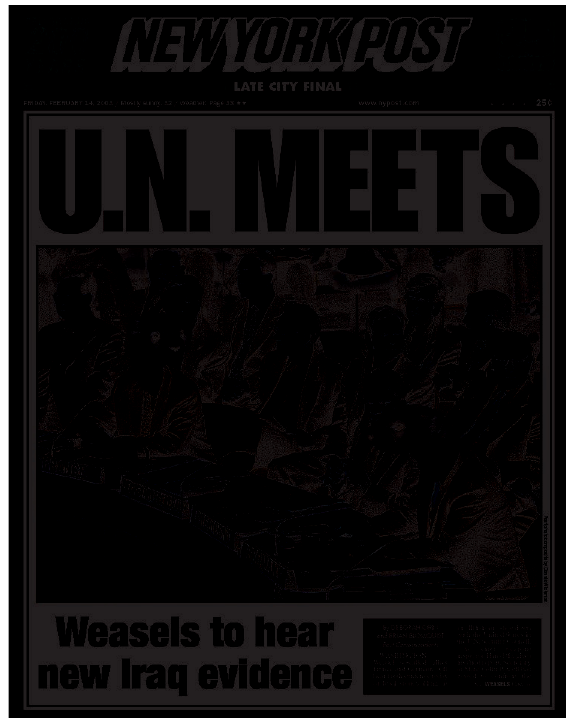
Figure 2. Cover of The New York Post, February 14,